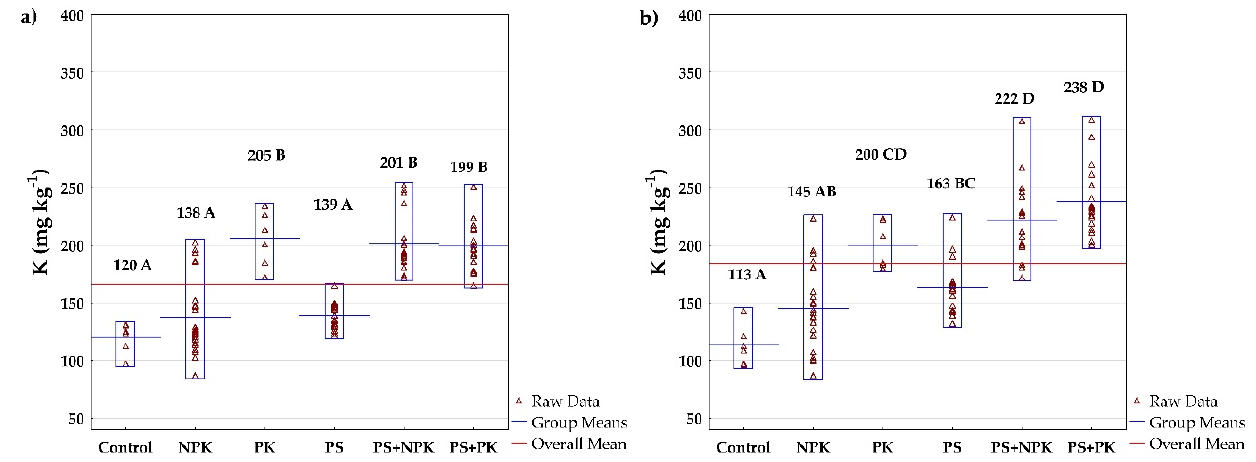
Figure 3. The effect of fertilizer treatments on soil K concentration in ( a ) Pernolec and ( b ) Kostelec (2015–2020). Mean values followed by the same letter are not significantly different. Red triangles represent the raw data. The blue lines represent the mean value of the particular treatment, while the red line represents the mean value calculated from all fertilizer treatments.